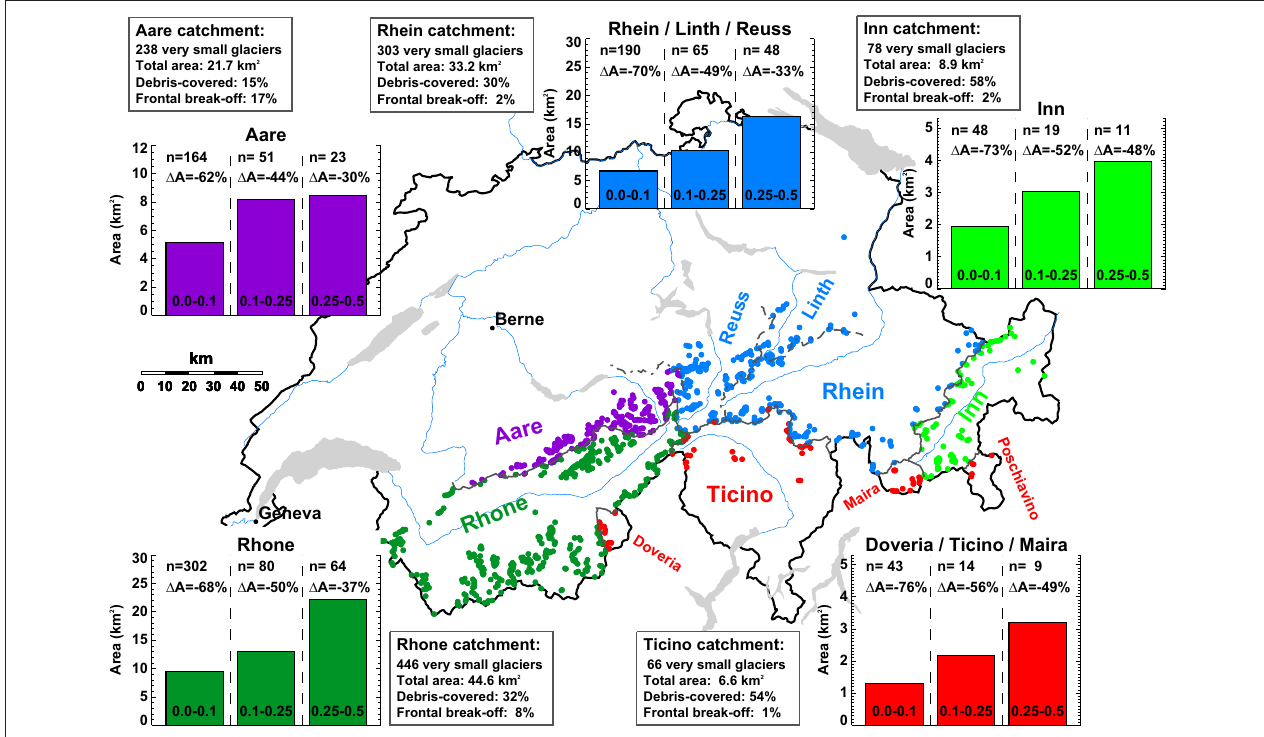
FIGURE 1 | Distribution of very small glaciers in the Swiss Alps. Glacier count and area in three size classes for the major hydrological basins and the relative area changes 1973–2010 are stated. The percentage of glaciers with supraglacial debris and affected by frontal break-off of ice per catchment is given. Note that the basin of the Rhine River has been separated into two sub-catchments (Aare, Rhein/Linth/Reuss).